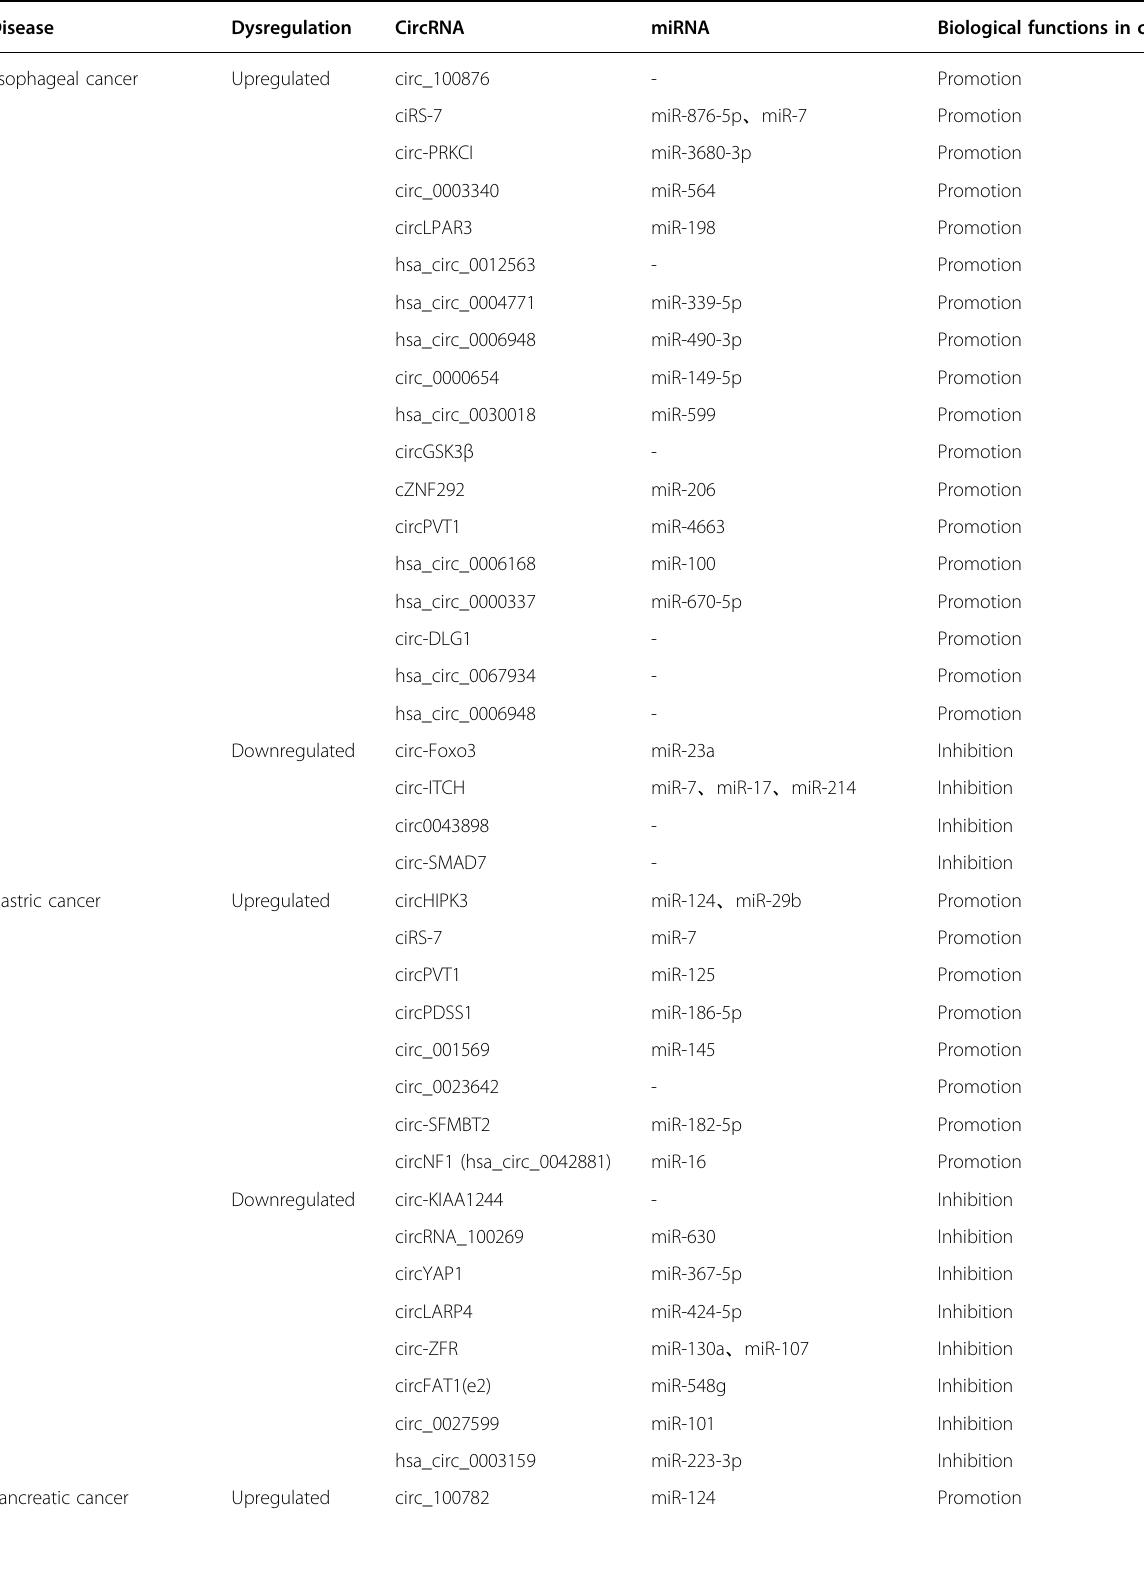
Table 1 Some important circRNAs in the digestive